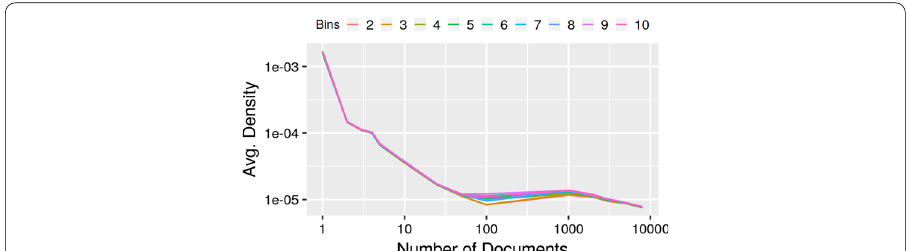
Fig. 26 Average density over time, per number of bins, for the TF-bins model